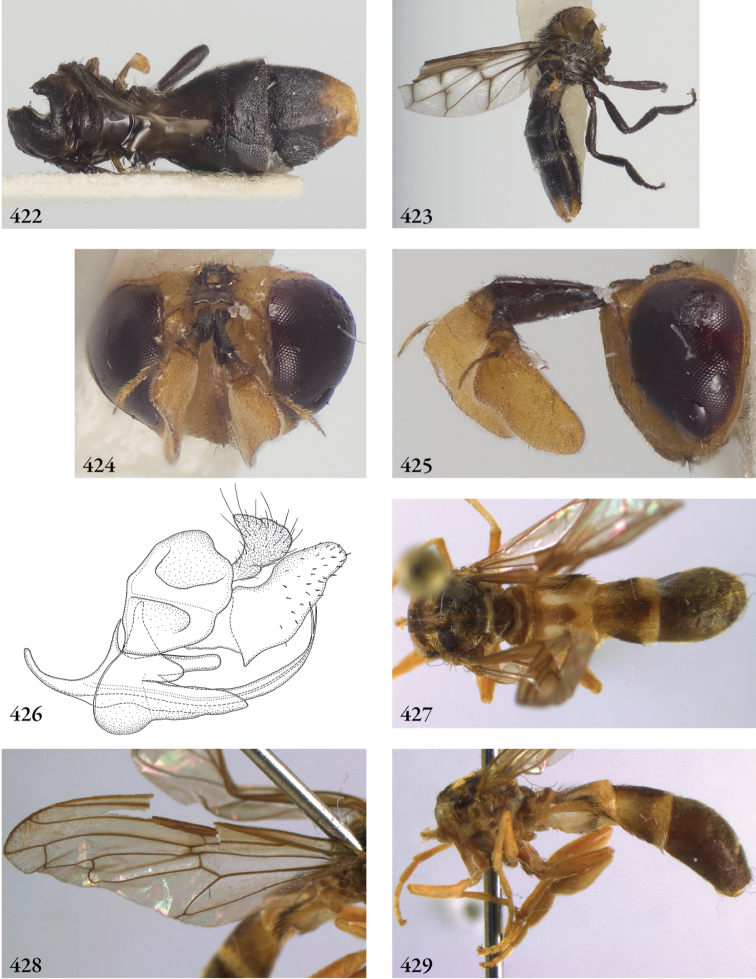
422–426 Undescribed genus #1 species AUS-01 Thompson in prep., male (Australia, coll. USNM): 422 habitus dorsal 423 habitus lateral 424 head frontal 425 head lateral 426 genitalia lateral 427–429 Undescribed genus #2 species MCR-2 Thompson in prep., male (Costa Rica, coll. RMNH): 427 habitus dorsal 428 wing 429 habitus lateral.